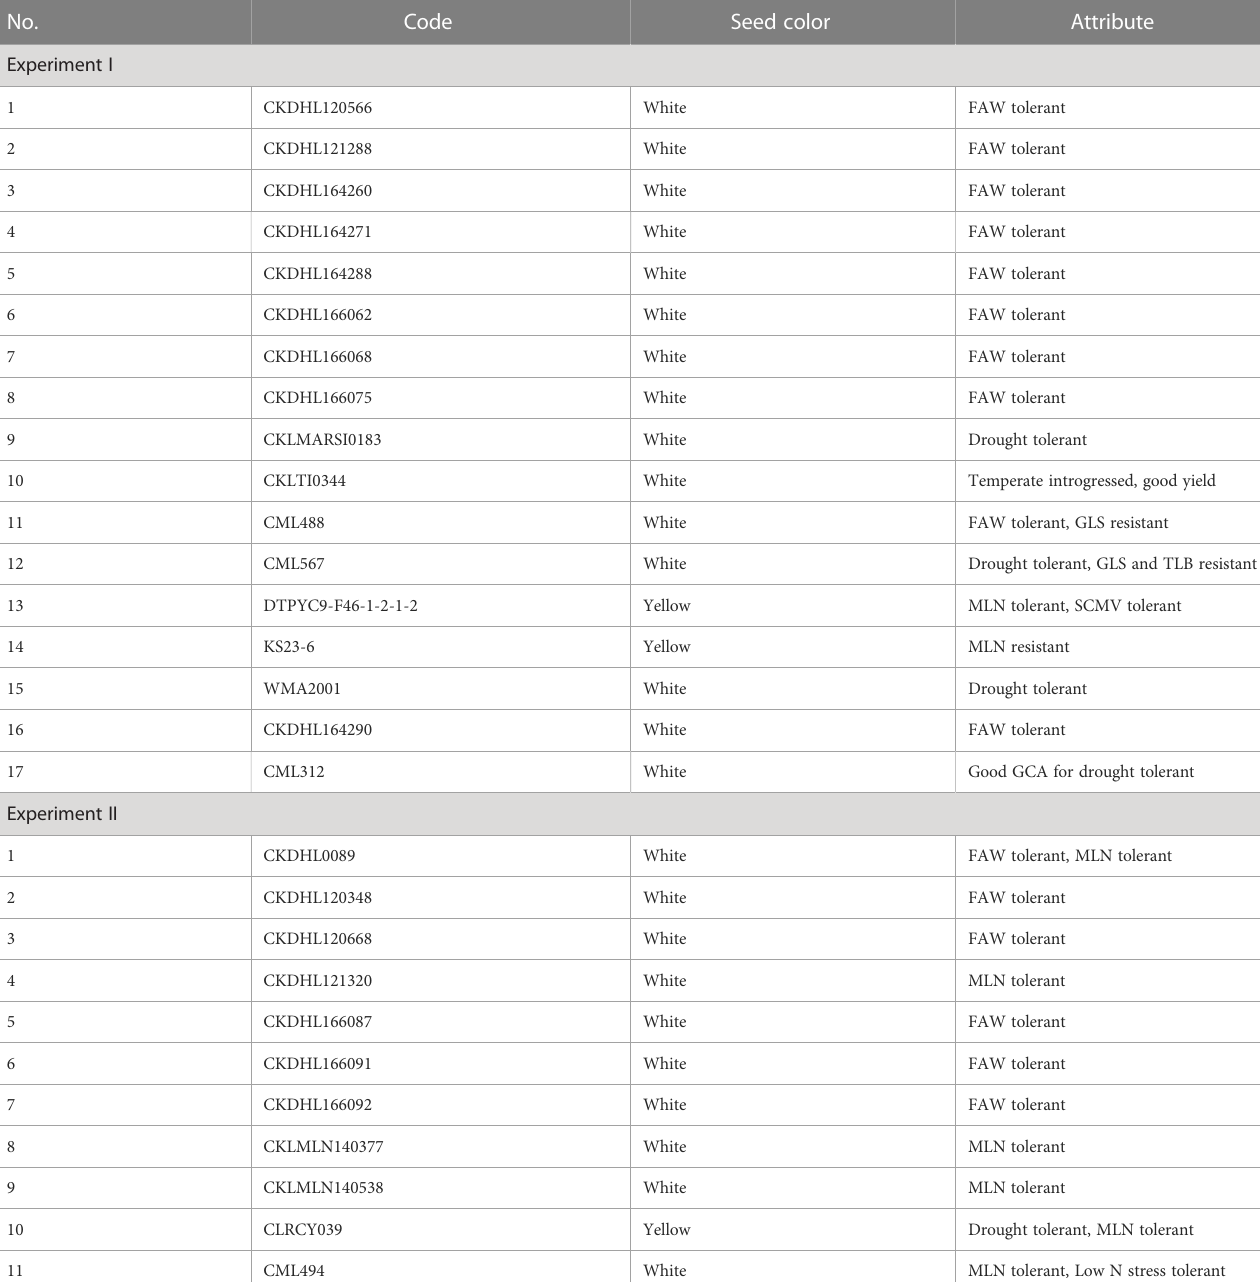
White MLN tolerant, Low N stress